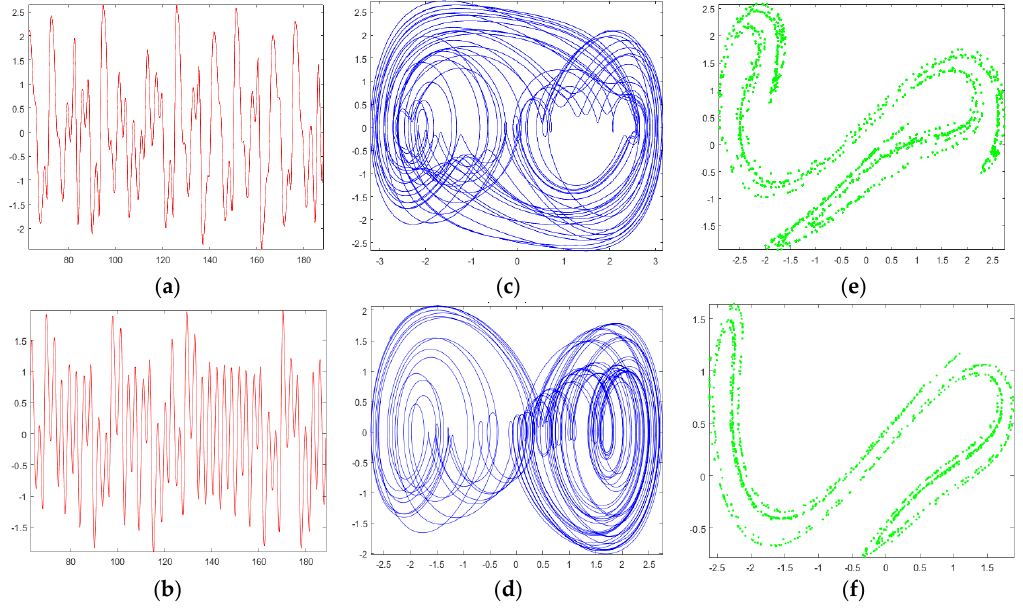
Figure 1. Chaotic Duffing map with two different sets of parameters. ( a , b ) Times series plots, ( c , d ) Phase space plots; ( e , f ) Poincare diagram. Table 1. NIST randomness measure for Duffing map chaotic sequences. √ means test is passed. p Values for Each Chaotic Sequences